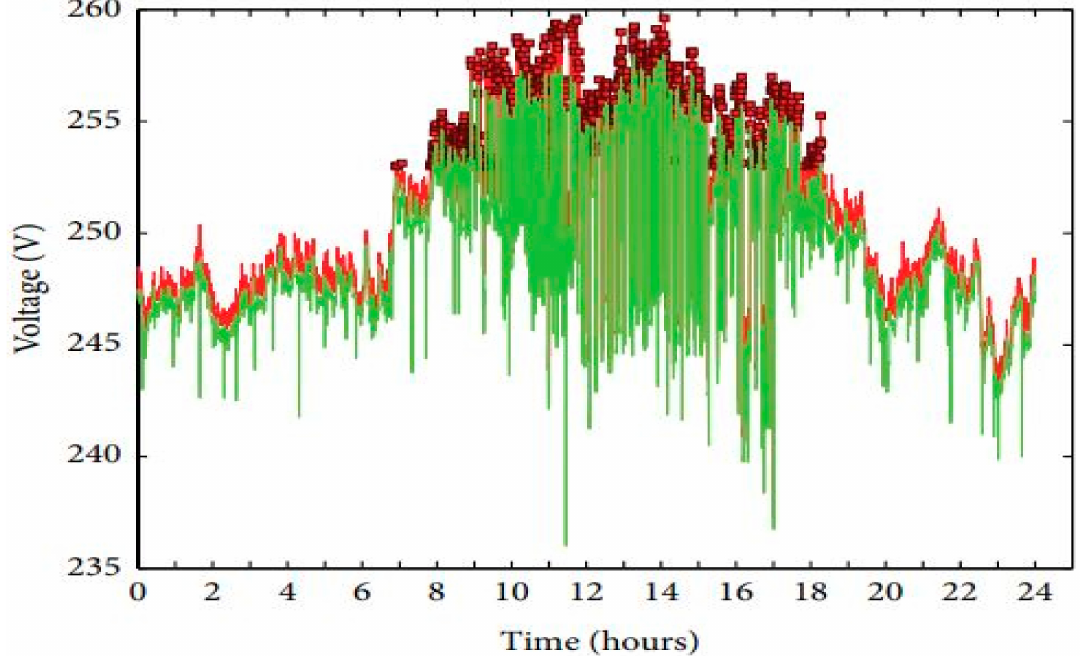
Figure 11. The voltage profile recorded in the second facility. The green shows the minimum voltages, the black shows the medium voltages, and the red signifies the maximum voltages